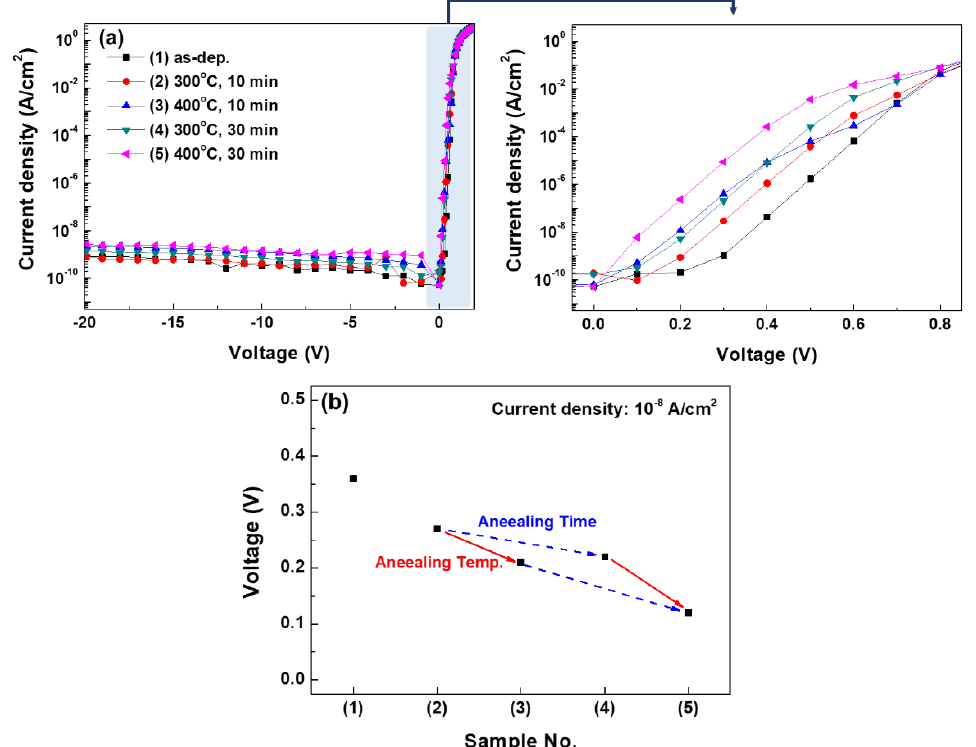
Figure 3. Typical forward and reverse J–V characteristic curves of Mo / SiC Schottky contacts with various annealing conditions: ( a ) J–V characteristic curves; ( b ) change of forward voltage by annealing temperature and time (current density = 10 − 8 A/cm 2 ).